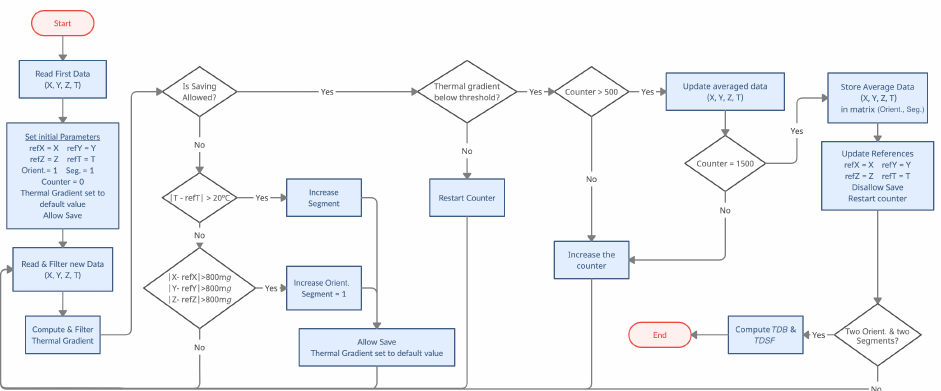
Figure 3. Working flow of the proposed